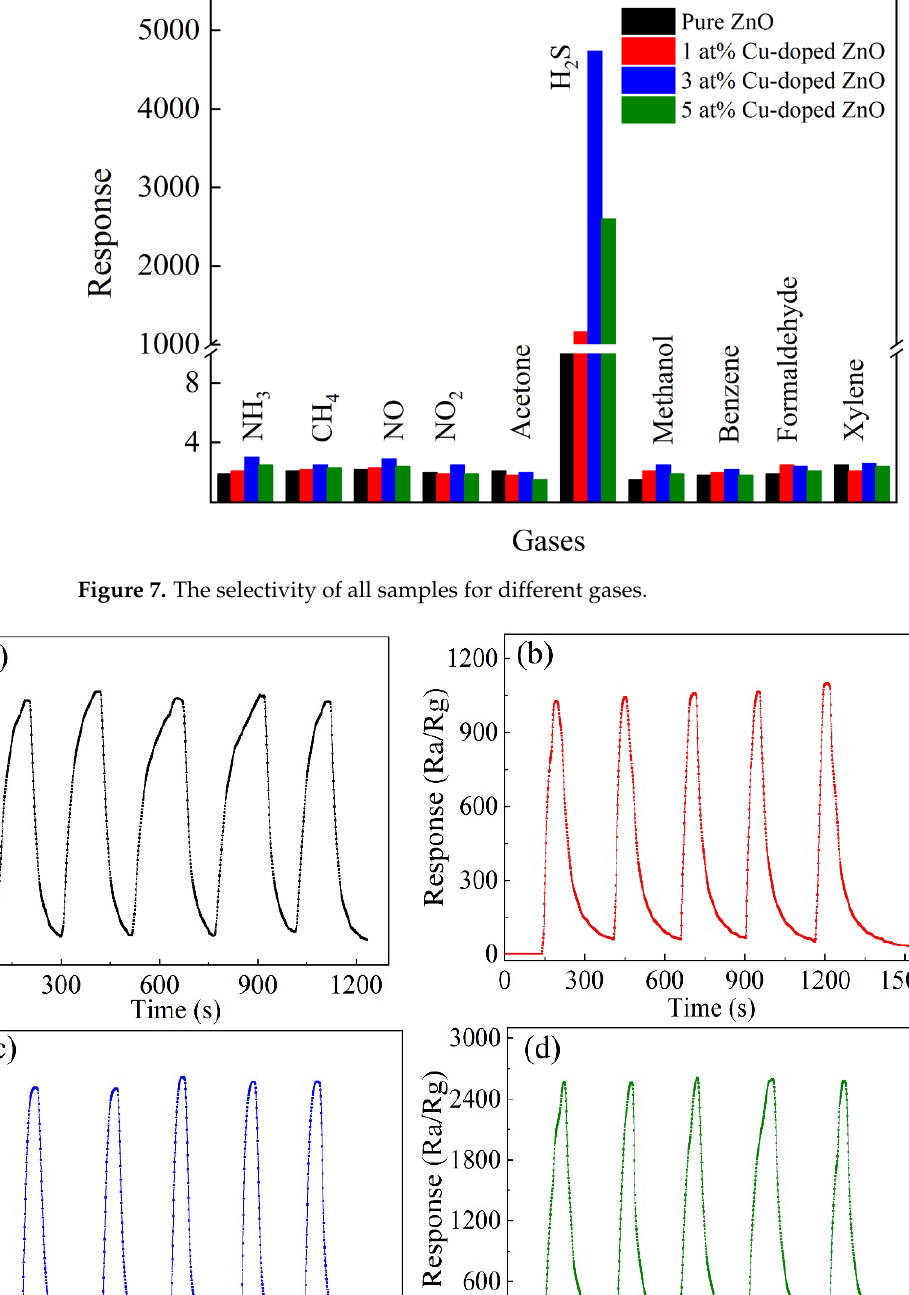
Figure 8. The stability of different samples for 5 ppm H 2 S at their optimum operating temperatures: ( a ) pure ZnO nanocages, ( b ) 1 at% Cu-doped ZnO nanocages, ( c ) 3 at% Cu-doped ZnO nanocages, and ( d ) 5 at% Cu-doped ZnO nanocages.